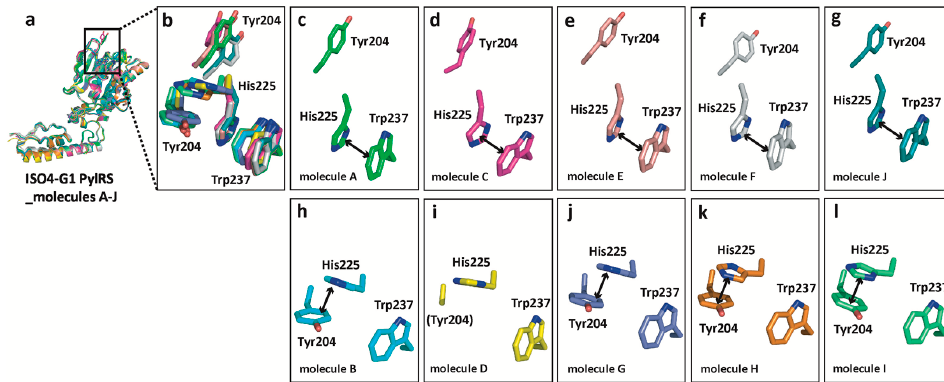
Figure 5. His225 undergoes drastic conformational changes in accordance with the β 5- β 6 hairpin. Superimposition of the ISO4-G1 PylRS molecules A to J ( a ). The superimposed Tyr204, His225, and Trp237 residues are shown as stick models ( b ). The Tyr204, His225, and Trp237 residues in the ten ISO4-G1 PylRS molecules are each colored green ( c , molecule A), magenta ( d , molecule C), vermilion ( e , molecule E), white ( f , molecule F), turquoise blue ( g , molecule J), cyan ( h , molecule B), yellow ( i , molecule D), lavender ( j , molecule G), orange ( k , molecule H), and light green ( l , molecule I). In molecules A, C, E, F, and J, a π – π stacking interaction is observed between His225 and Trp237 ( c – g